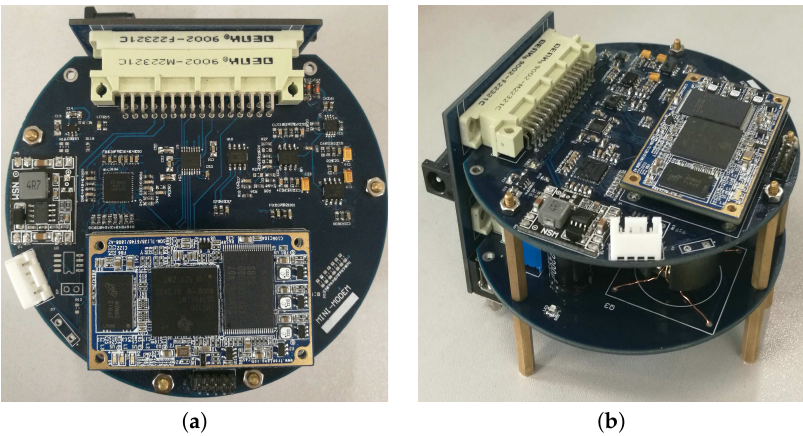
Figure 7. Experimental prototype of the micro-modem; ( a ) Digital board of the micro-modem; ( b ) Modem